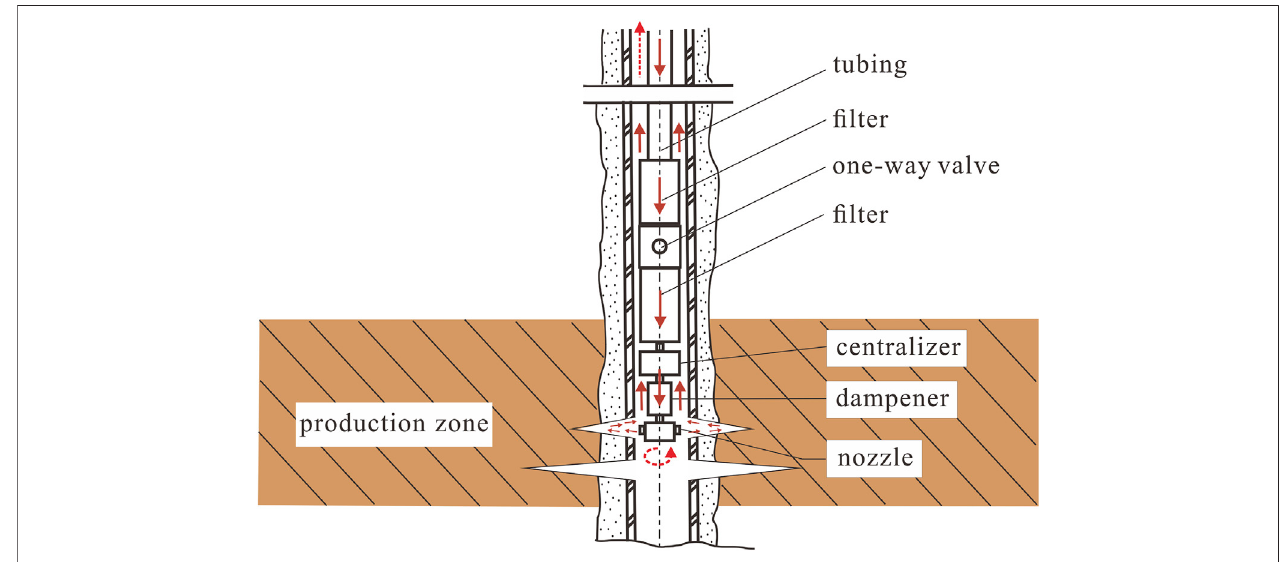
FIGURE 1 | Schematic of bottomhole assembly of the high-pressure rotating water jets tool.